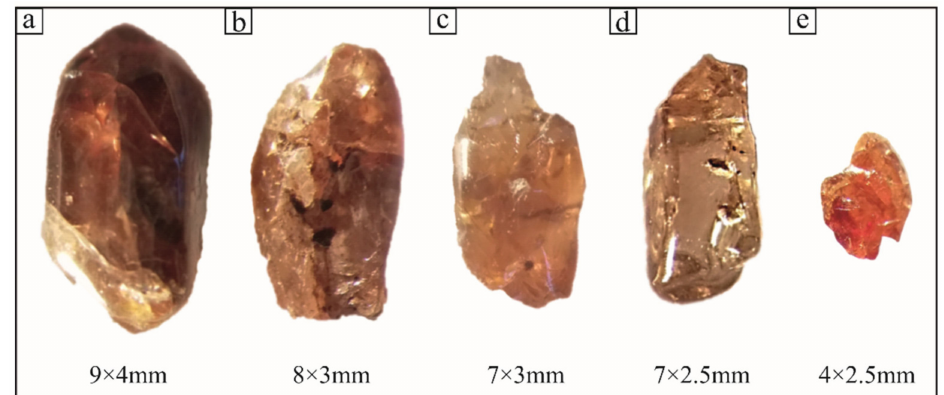
Figure 3. Representative crystals of zircon from Le Fosse di Novale ( a – c , e ) and Lonedo ( d ).